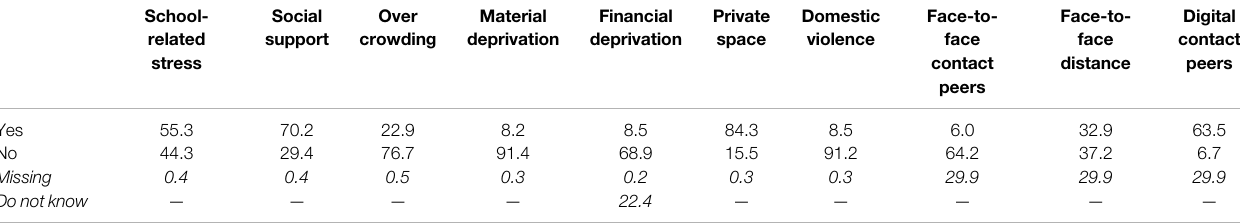
— — — — — — — — — The italic values are merely respondents that were either missing or do not